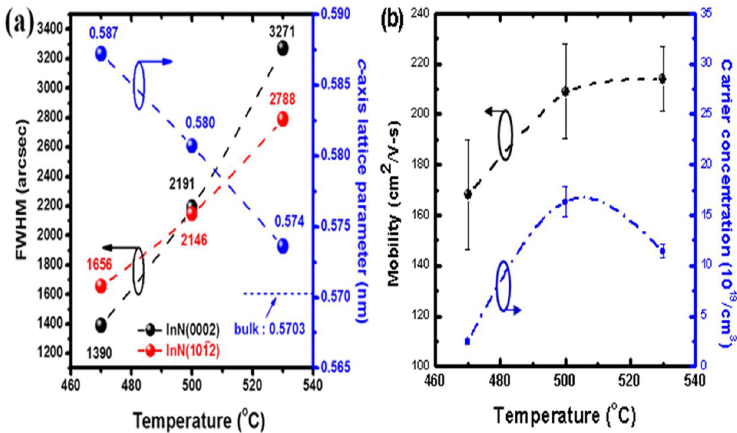
Figure 3. ( a ) FWHM of InN(0002) (black solid circle) and InN( 2110 ) (red solid circle) and c-axis lattice parameter of the InN samples (blue solid circle). ( b ) Carrier concentration and mobility measured by Hall measurement.